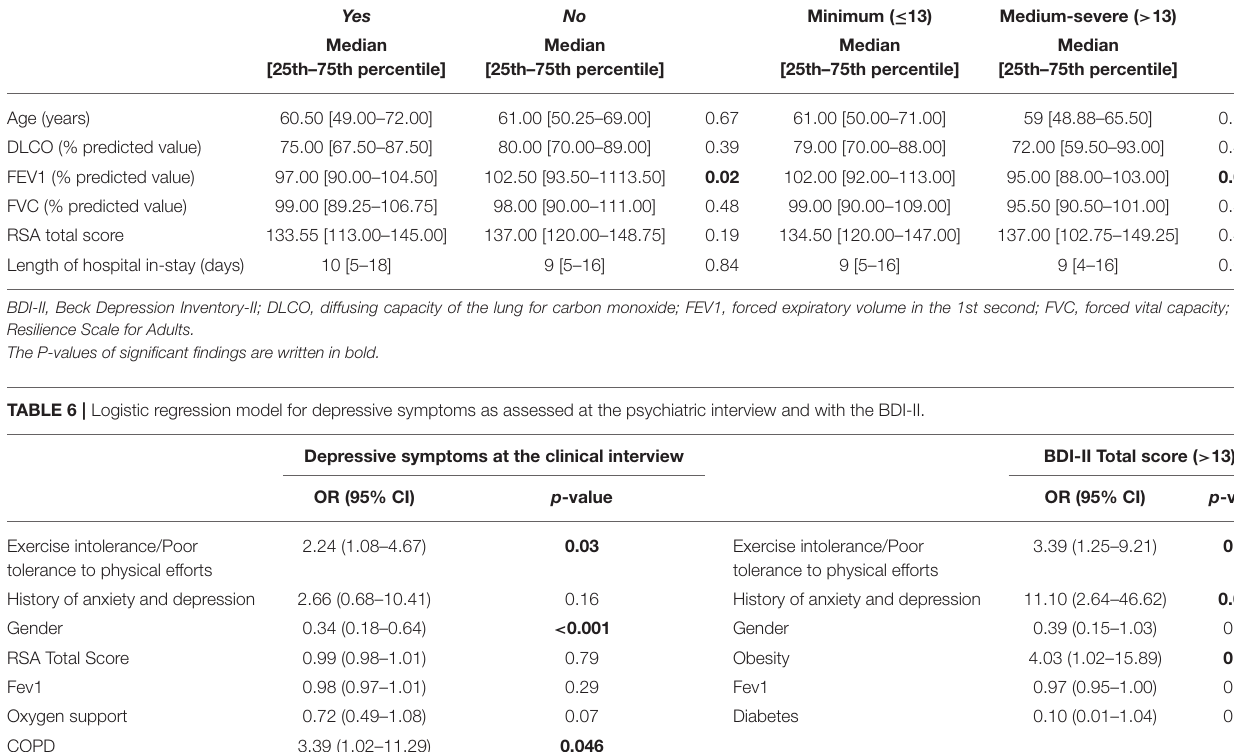
TABLE 5 | Depressive symptoms as assessed at the psychiatric interview and with the BDI-II: Mann-Whitney test results. Depressive symptoms at the clinical interview